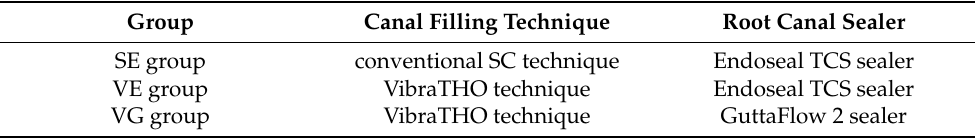
Table 1. The canal filling techniques and root canal sealers assigned to each experimental group.